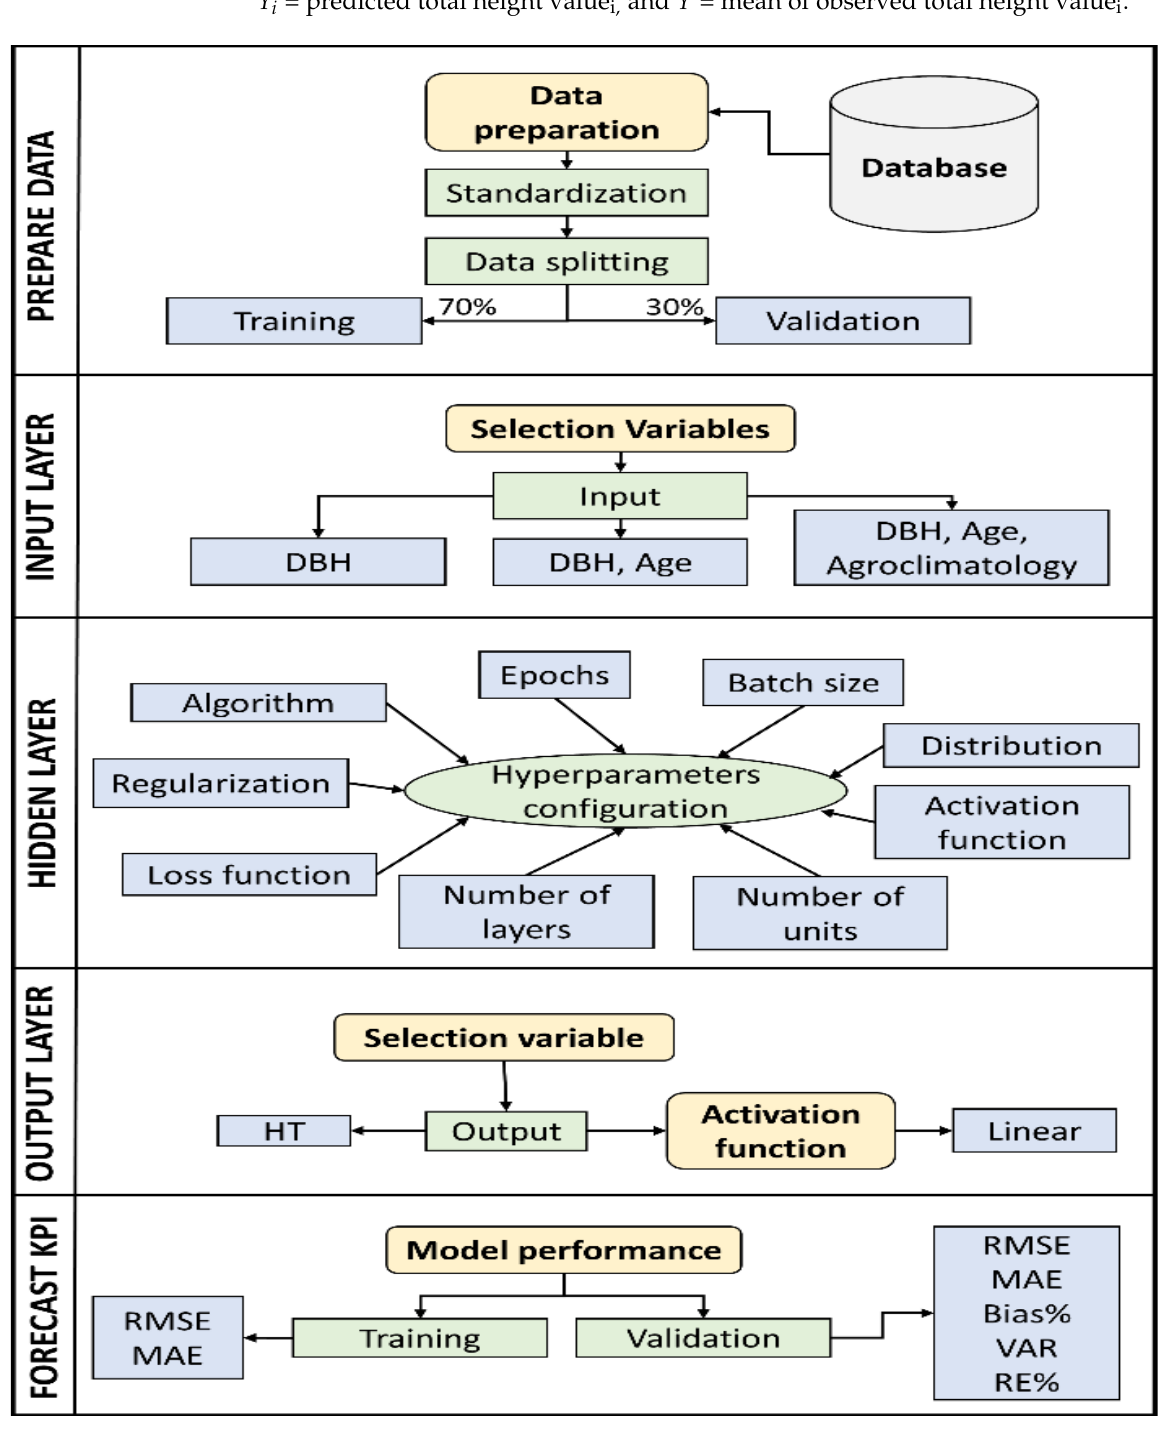
Figure 3. Methodological flow diagram established in our study for the hypsometric modeling of Guazuma crinita Mart. trees in the Peruvian Amazon.